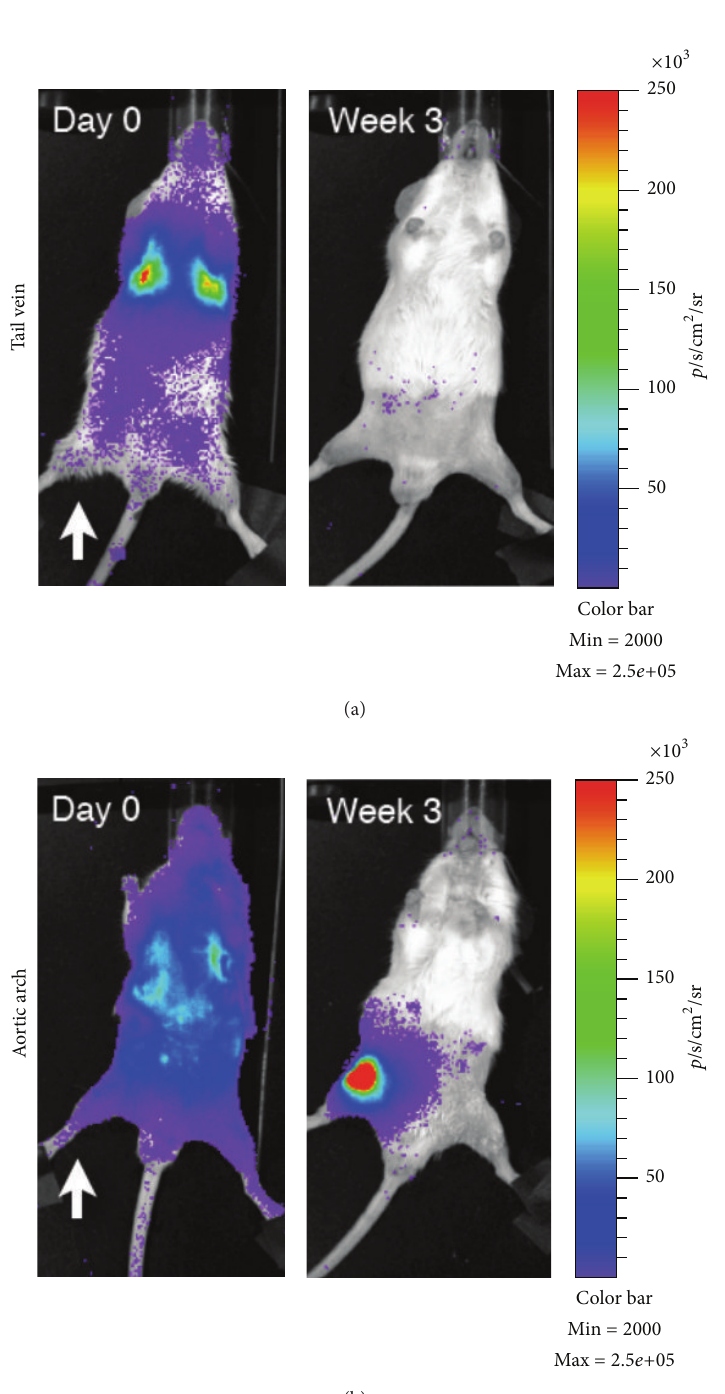
Figure 1: Comparison of intravenous and intra-arterial cell delivery. Mice were irradiated unilaterally (white arrow) before injection IV (tail vein; a) or IA (aortic arch; b) with 1 × 10 6 BMC9 MSCs expressing a luciferase